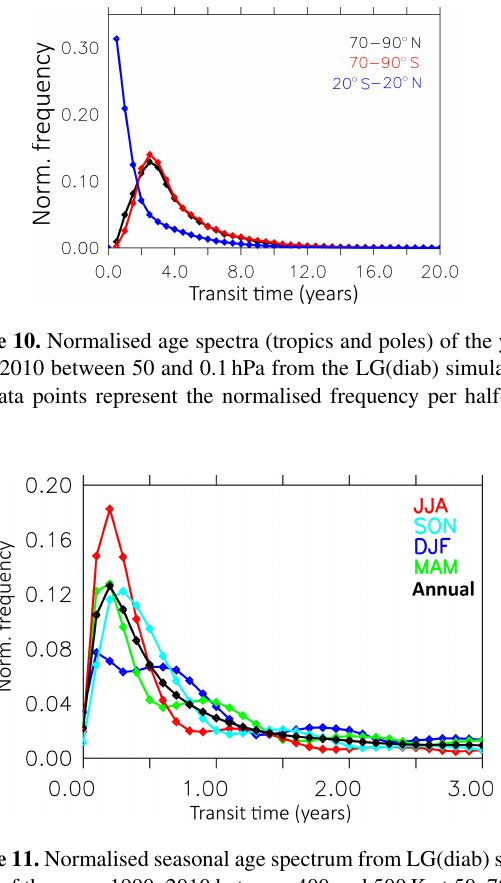
Figure 11. Normalised seasonal age spectrum from LG(diab) simu- lation of the years 1990–2010 between 400 and 500K at 50–70 ◦